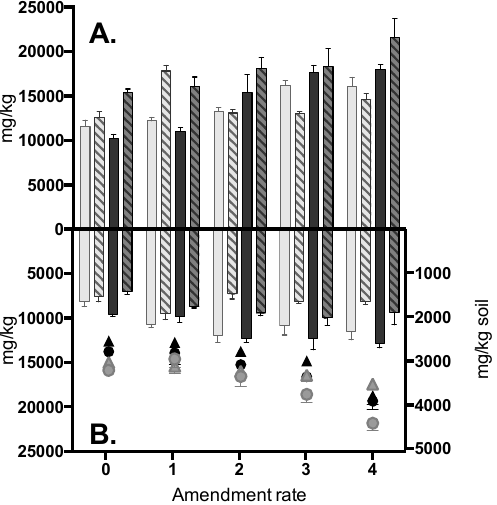
Figure 4. The potassium concentration of shoots ( A ) and roots ( B ) grown in Freeman (light grey) or Bernhill (dark grey) soils amended with KB- (solid) or wood- (cross- hatched) sourced biochars. The potassium of the soils (right axis, (B)) is also plotted for Freeman (light grey) or Bernhill (dark grey) soils amended with KB- (circle) or wood- (triangle) sourced biochars (Trippe 2015). Amendment rates are represented as 0–4, which correspond to rates of 0%, 3%, 6%, 16%, and 25% by volume for both biochars, 0%, 0.7%, 1.7%, 3.7%, and 8.6% by mass for wood biochar, and 0%, 0.4%, 1.2%, 2.5%, and 5.8% by mass for KB-sourced